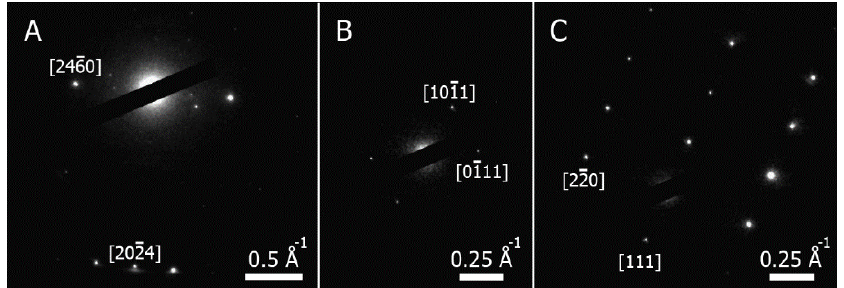
Figure 5. Electron diffraction images of crystallites in: ( A ) Si:S5 sample, indexed according to 2H-Si phase; ( B ) Si:S2 sample, indexed according to 4H-Si, angle between directions equaled 57°; ( C ) Si:Te sample, indexed according to the cubic phase.